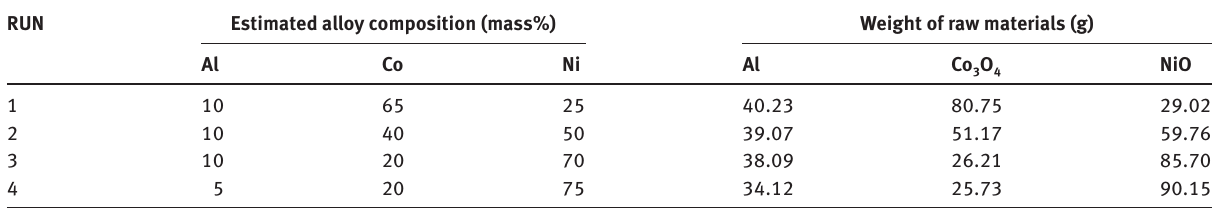
Table 1: Estimated alloy compositions and amounts of raw materials used in SHS reactions